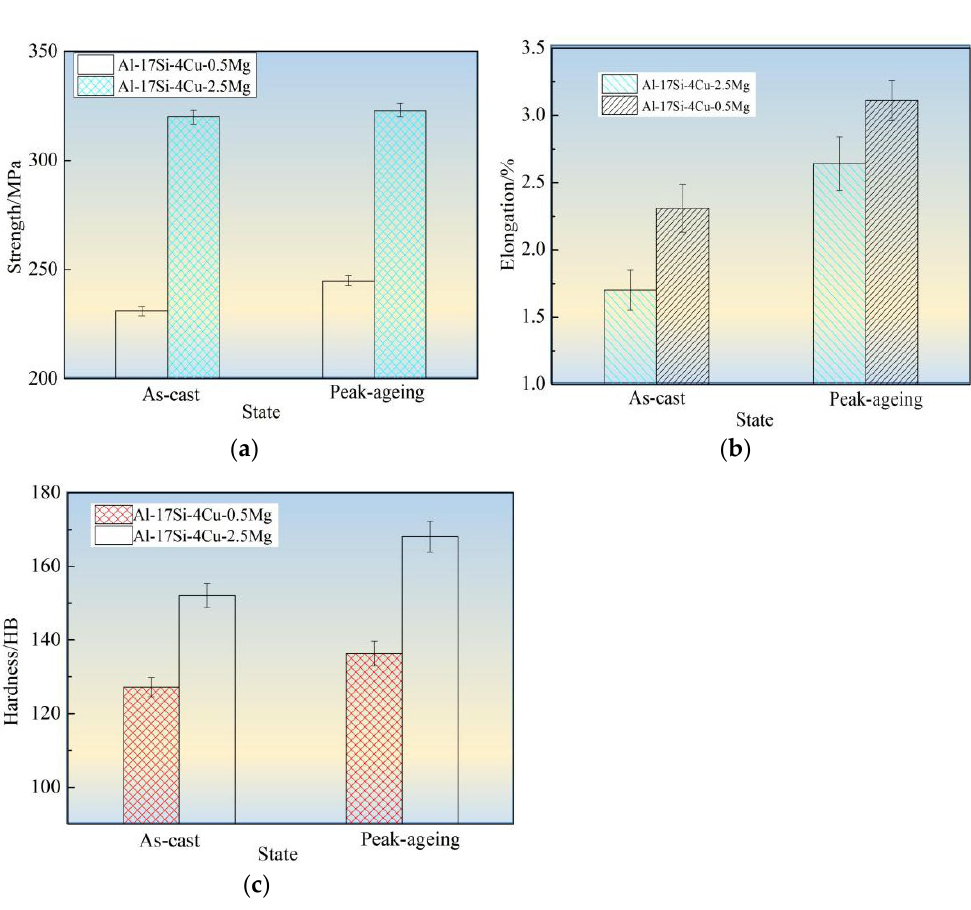
Figure 10. Mechanical performances for hypereutectic Al − 17Si − 4Cu − xMg alloys. ( a )Tensile strength; ( b ) Elongation; ( c ) Hardness.